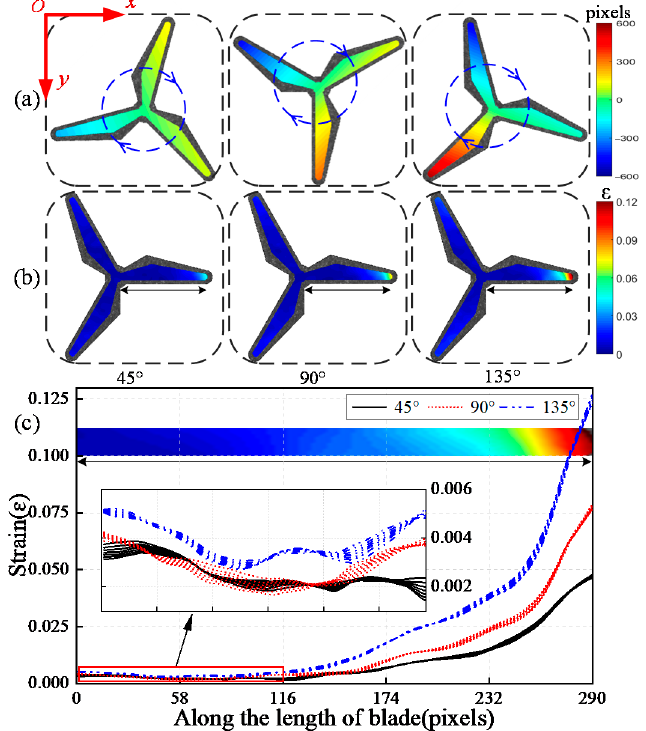
Figure 6. Distribution of full-field deformation in y -direction: ( a ) Displacement; ( b ) Strain; ( c ) Curve of strain.